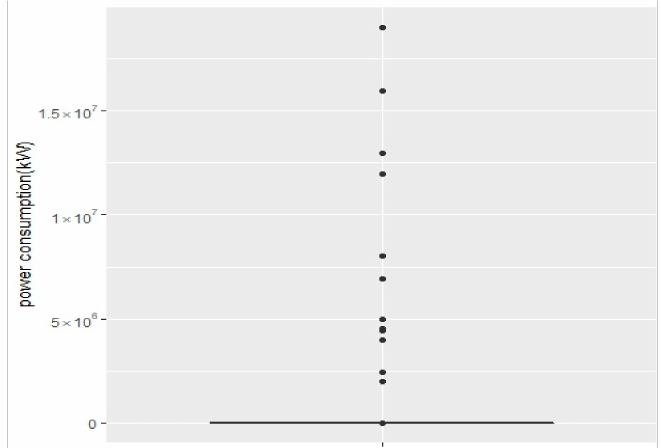
Figure 2. Boxplot with